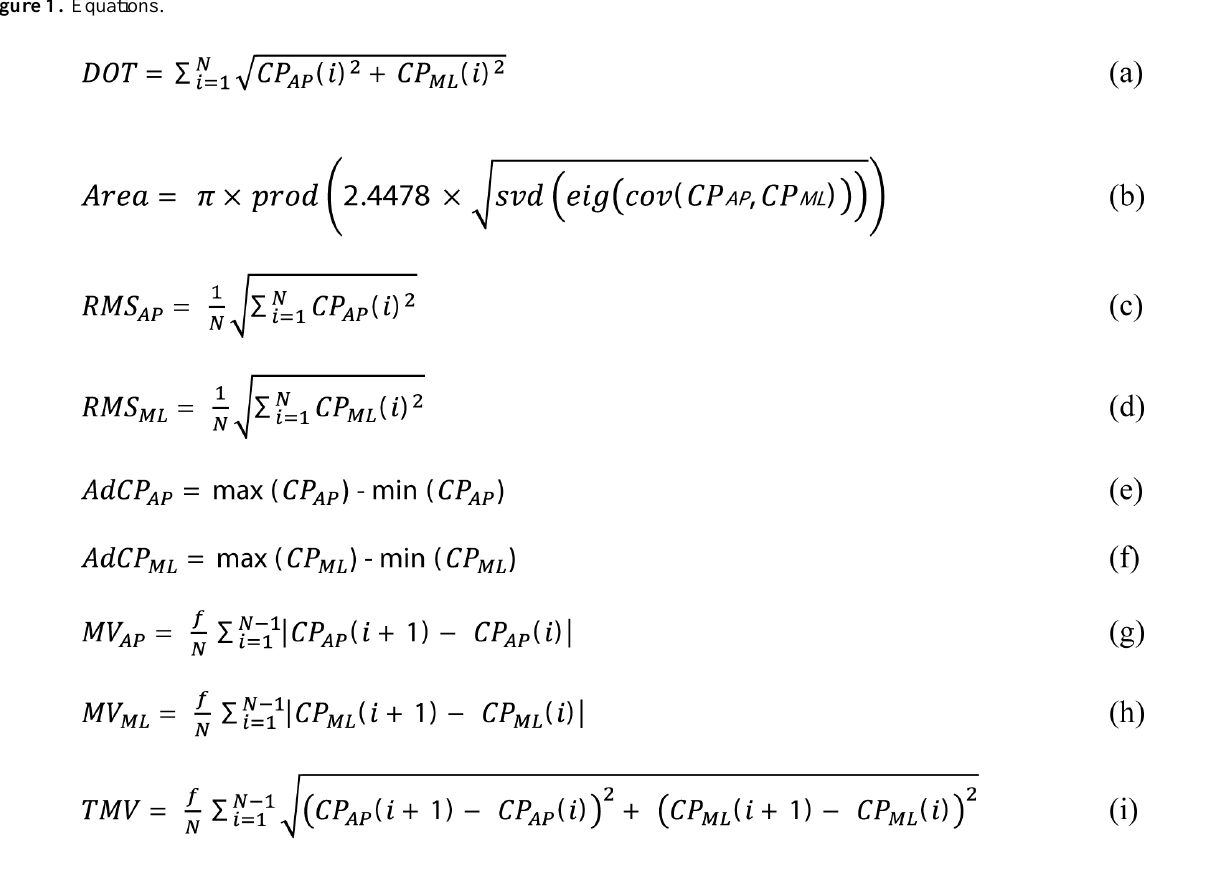
Figure 1. Equations.